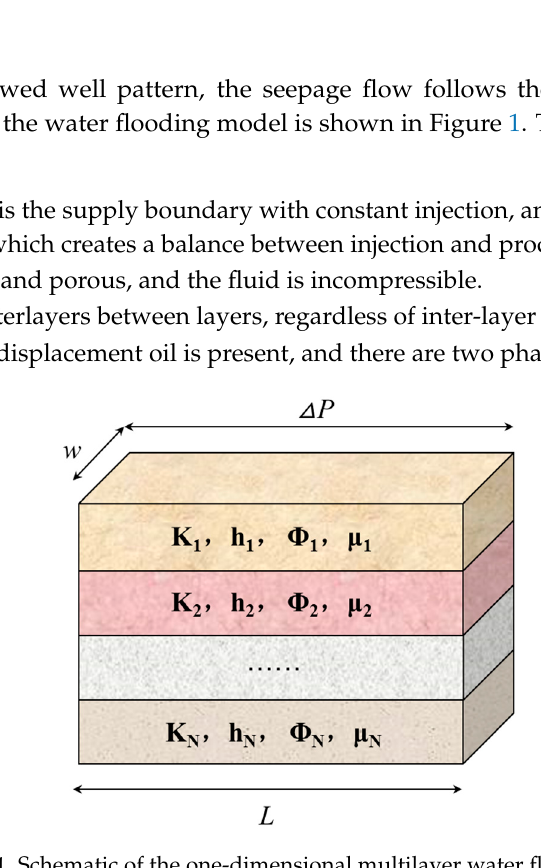
Figure 1. Schematic of the one-dimensional multilayer water flood model.